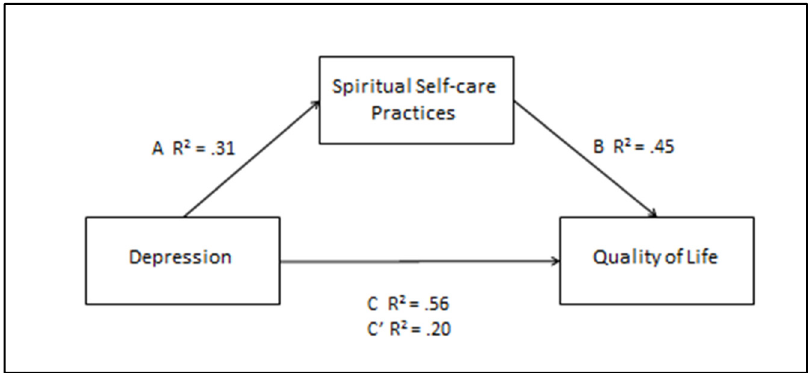
Table 4. Mediation analysis of the mediating role of spiritual self ‐ care practices on the relationship